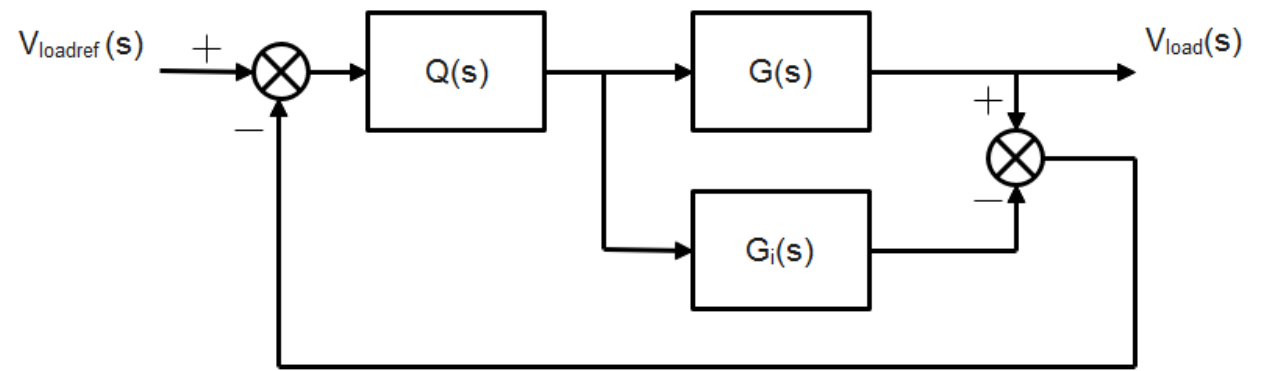
Figure 3. The internal model control of the feedback scheme.